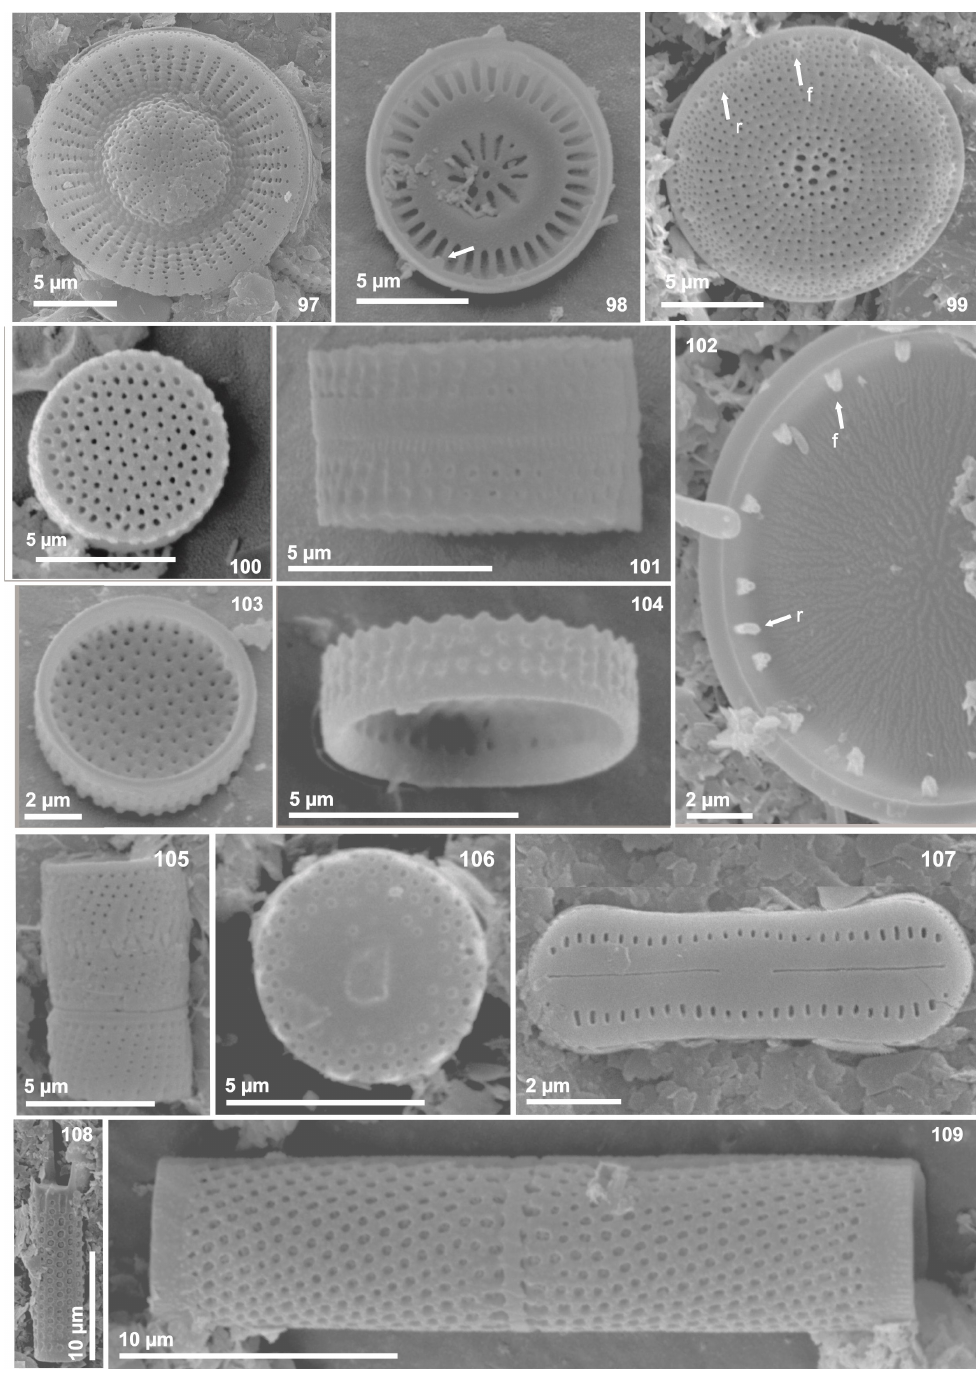
Figures 97-109. Diatom assemblages (Bacillariophyta) in six tropical reservoirs (São Paulo, Brazil). SEM views. 97-98. Discostella stelligera . 97. External valve view with details of the convex central area. 98. Internal valve view with convex central area and alveolate stellate pattern. Note marginal fultoportulae between every costae. 99, 102. Spicaticribra rudis . 99. External valve view with larger central areolae. Note position of rimoportula (arrow r) and fultoportulae (arrow f). 102. Internal valve view. Note position of rimoportula (arrow r) and fultoportulae (arrow f). 100-101, 103-104. Aulacoseira tenella . 100. External valve view. Flat valve face with small areolae. 101. Frustule in girdle view showing the straight, inclined to the right (dextrorse) areolae. 103. Internal valve view. 104. Detail of the mantle areolae and very short spines. 105-106. Aulacoseira pusilla . 105. External girdle view. Note the short spines located at the end of each two pervalvar costae. 106. Valve face. 107. Humidophila biscutella . External valve view. 108. Aulacoseira granulata . Valve view of the terminal cell of chain and a very long spine. 109. Aulacoseira ambigua . Girdle view of two valves. Note the fascia. Scale bars: Figs 97-101, 104-106: 5 μm; Figs 102-107: 2 μm; Figs 108, 109: 10 Acta Limnologica Brasiliensia, 2018, vol. 30, e201